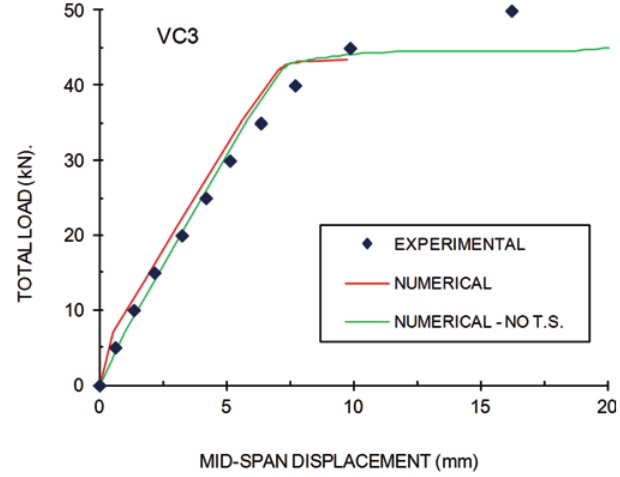
Comparison between numerical (ANEST/CA) and experimental results for beam VB6 tested by Juvandes [30]